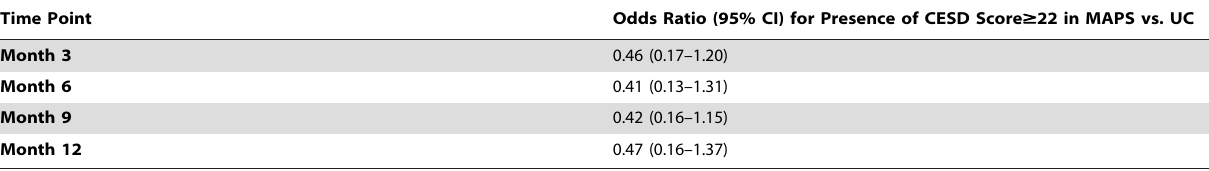
Table 2. Effect of MAPS on CESD Score . 22 at Each Time Point.